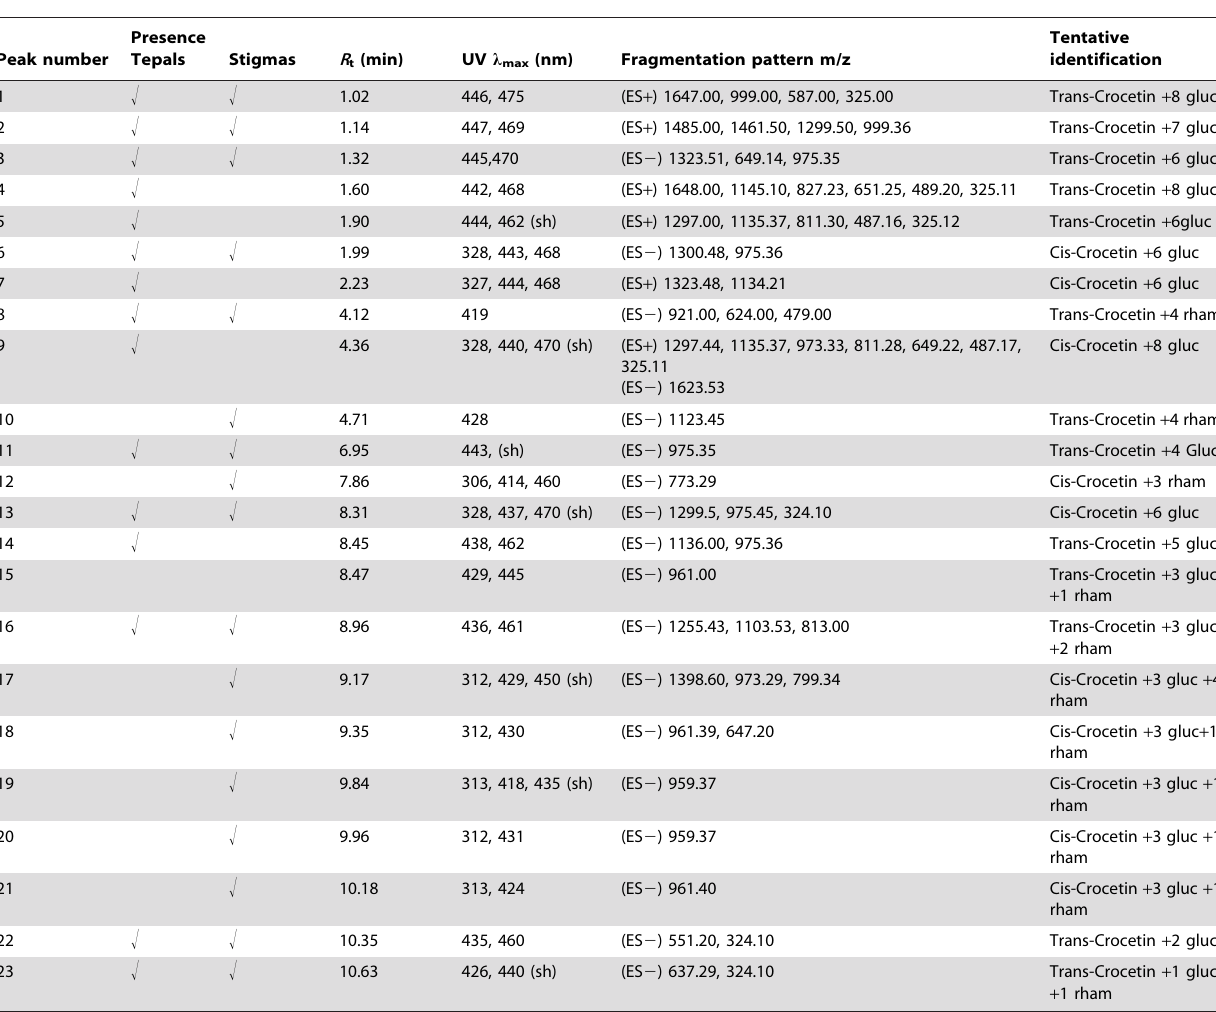
Data from negative and positive mode.